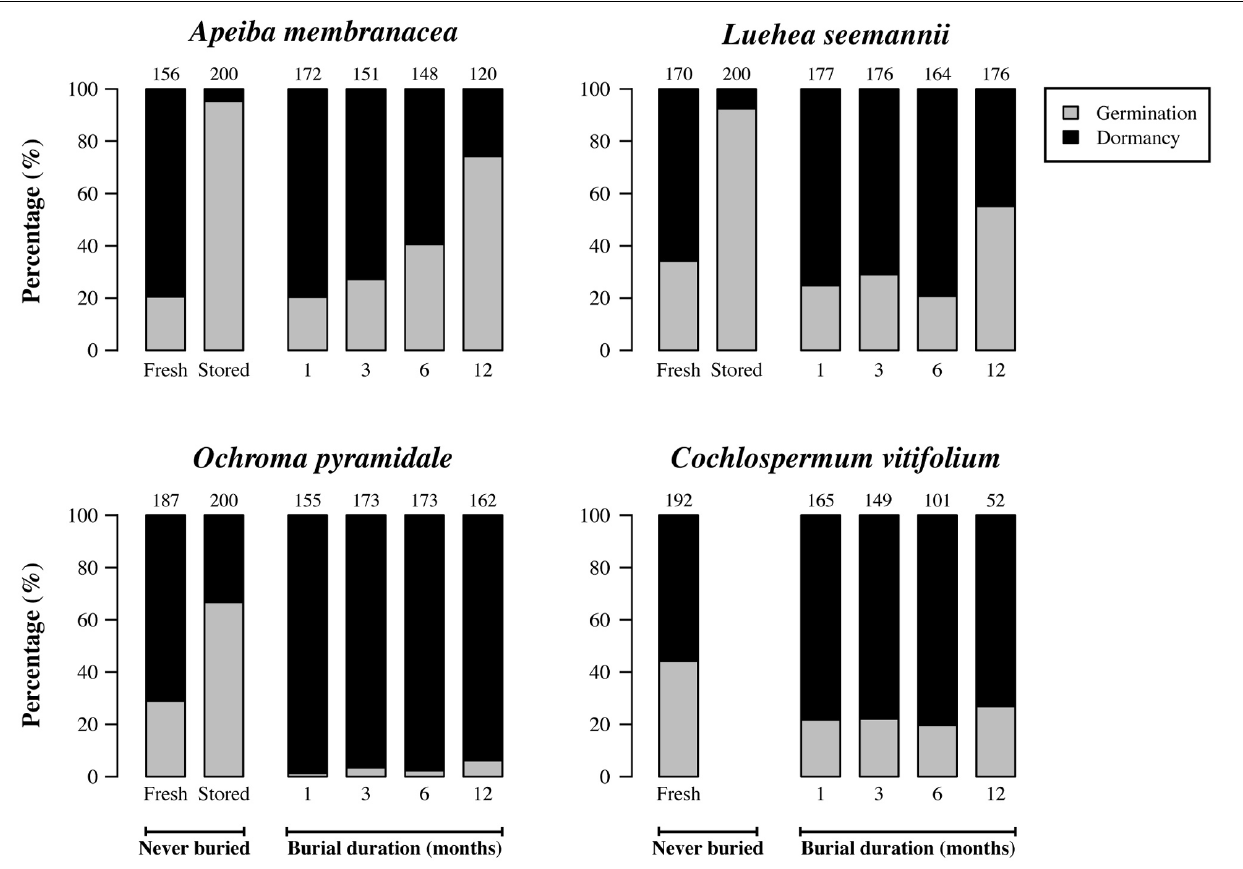
FIGURE 3 | Percentage of dormant seeds (black) and germinable seeds (gray) for fresh seeds; 2 years old, laboratory-stored seeds; and seeds successfully recovered at different time intervals after burial. Numbers at the top of each bar represent the number of